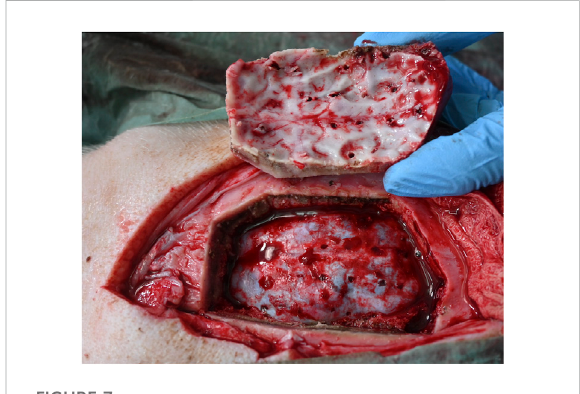
FIGURE 7 Nounintendeddamageisobservedinunderlyingtissue.Dura penetration can be seen only at the electrode insertion